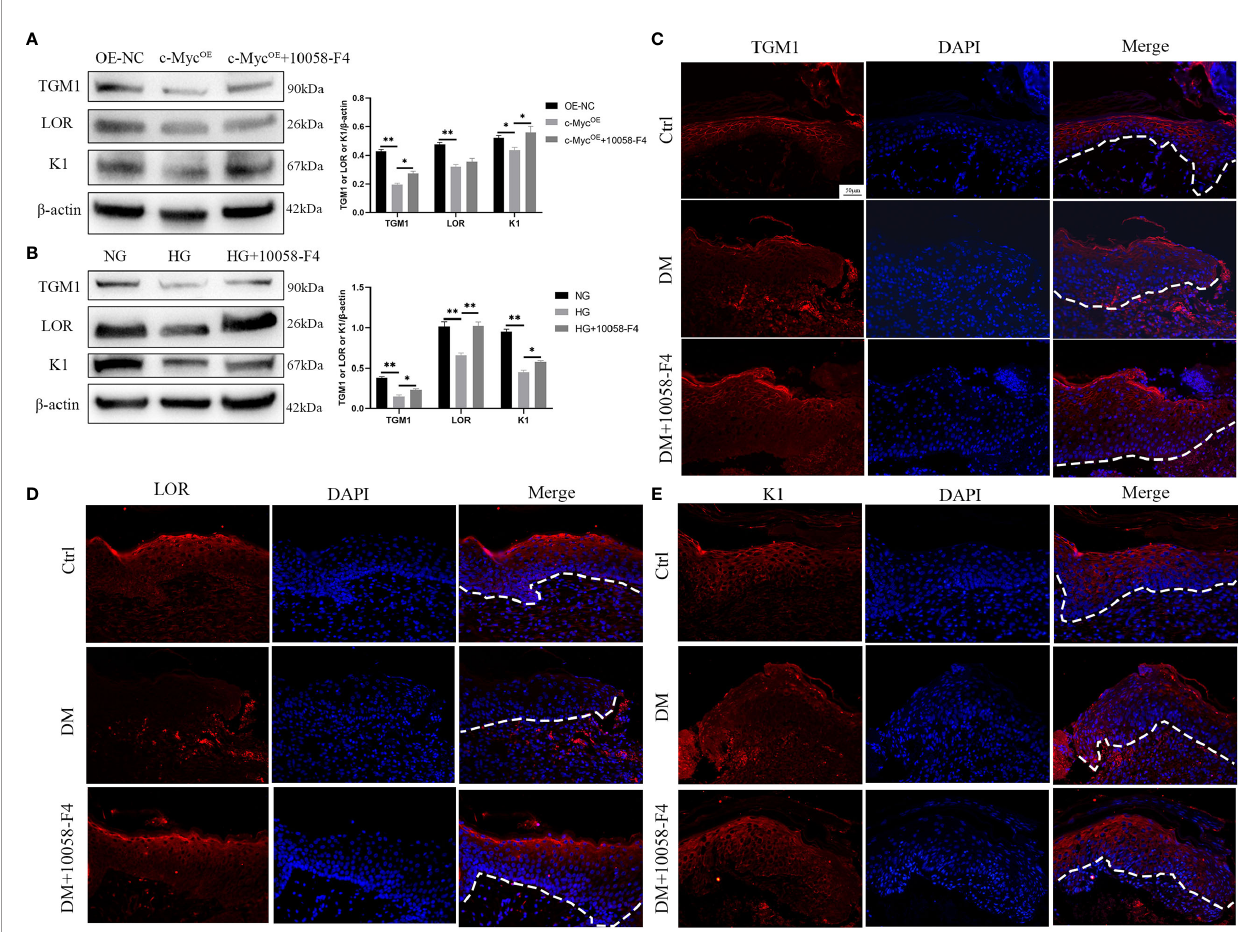
FIGURE 4 | Inhibition of c-Myc transcription activity alleviates the differentiation dysfunction caused by overexpression of c-Myc or high glucose (A, B) HaCaT cells were pre-treated with c-Myc transcription activity inhibitor (10058-F4, 20 m M) for 24 h, and then expressions of TGM1, LOR, and K1 were analyzed by western blot. (C – E) The wounds in the Ctrl and DM groups were treated with saline, while those in the DM+10058-F4 group were topically treated with 10058-F4 (30 mg/kg) every day for 11 consecutive days. Expressions of TGM1 (C) , LOR (D) , and K1 (E) were determined by immuno fl uorescence assay in day 11 wound margin tissues of rats. The nuclei were stained blue using DAPI. Magni fi cation: ×200, Scale bar = 50 m m. The white dotted line represents the epidermis-dermis dividing line. OE- NC, the negative control of c-Myc overexpression. Data were shown as the mean ± SEM measured in triplicate from three independent experiments. ANOVA followed by Tukey ’ s multiple comparisons test were performed to analyze the differences. * P < 0.05, ** P <